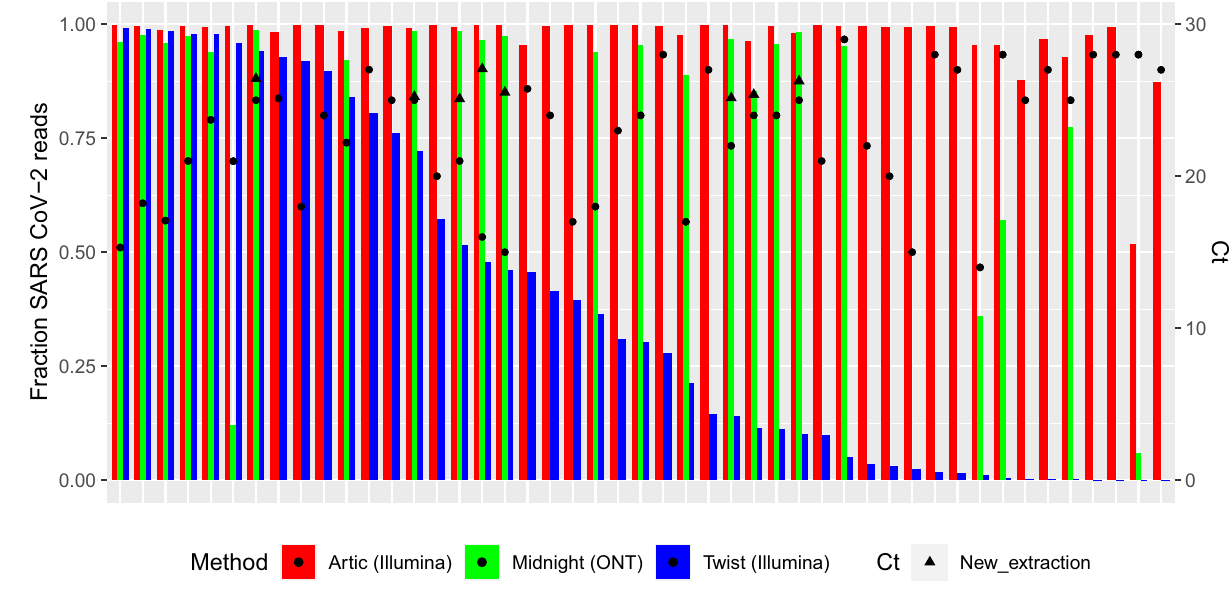
Figure 3. Performance of variation of mapped reads between methods for individual samples. Fractions of SARS CoV‑2 mapped reads in stacks. Ct values are indicated by black dots, and samples are sorted by decreasing Twist fraction. Twist bait hybridization enrichment (n = 47 patients), ARTIC tiled amplicon enrichment (n = 47 patients), Midnight tiled amplicon enrichment (n = 24